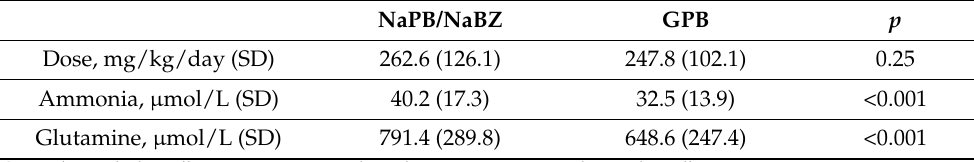
Table 2. Early switching: basal and first assessment after GPB introduction (T0-T1).